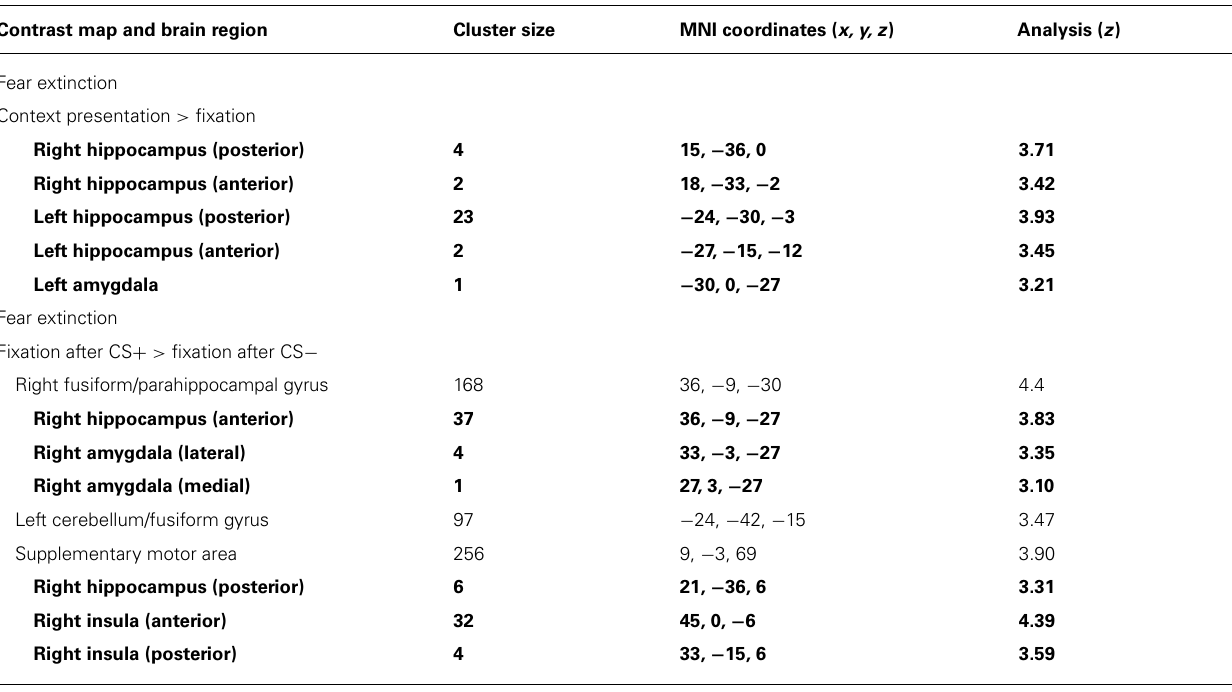
Table 2 | Correlations with CAPS total